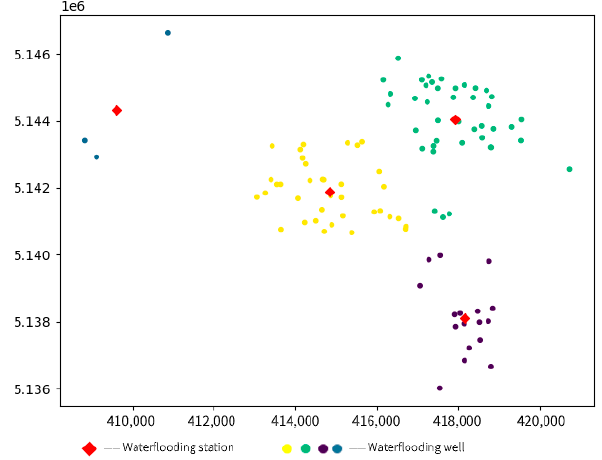
Figure 13. Clustering results.